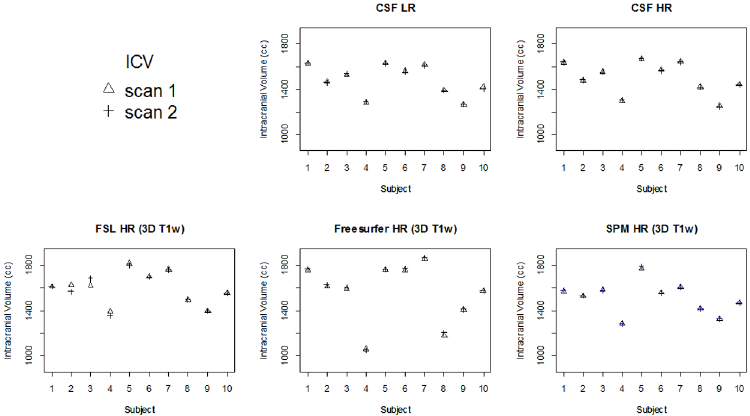
Fig 7. All ICV measurements for all methods in each subject. CSF LR = CSF low resolution MRI scan; CSF HR = CSF high resolution MRI scan.